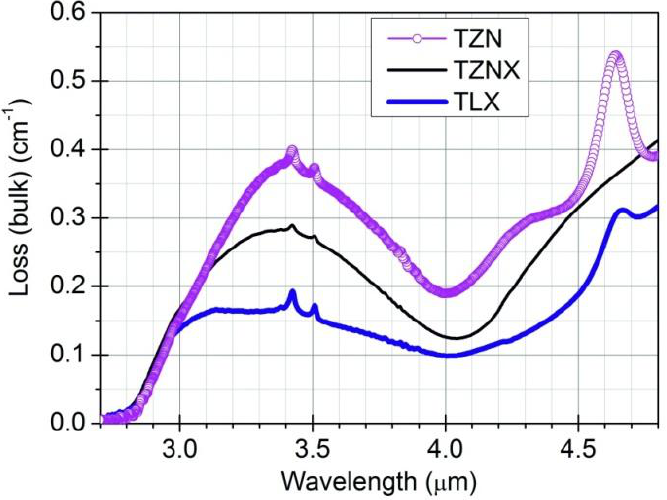
-20ZnO-5Na O 2 2